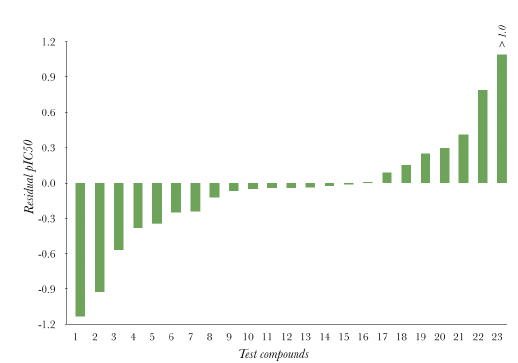
Fig. 2: Bar chart representations of the residual (Ex- perimental pIC 50 -Predicted pIC 50 values of the test dataset. Only 1 out of tested compounds (compound 23 , see supplementary Fig. 2 for structural details) showed > 1 . 0 pIC 50 unit (indication of wrong